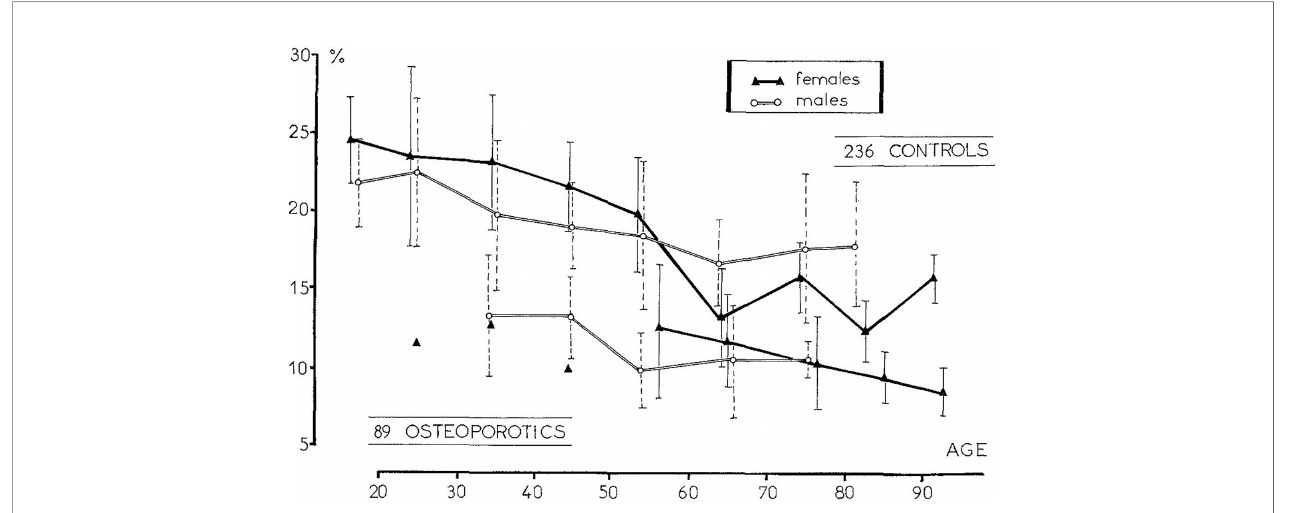
FIGURE 3 | The measurement of the trabecular bone volume in osteoporotic patients with one vertebral fracture allowed to de fi ne a “ vertebral fracture threshold ” at 11% [From Meunier et al.